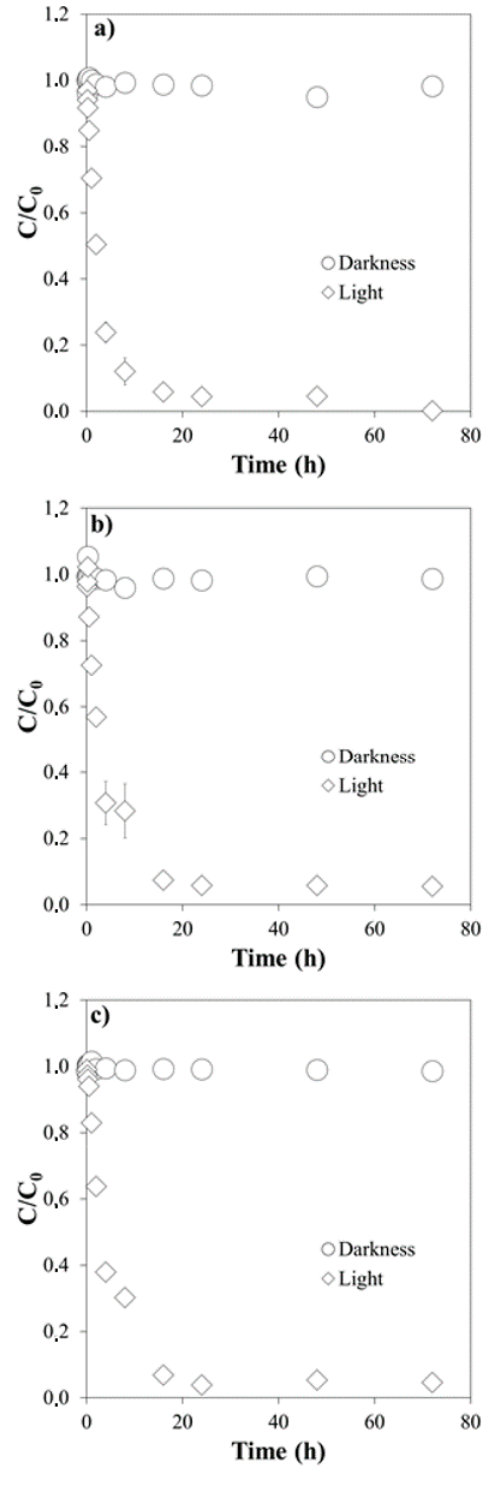
Figure 2. Degradation of Clarithromycin under simulated light and in the dark: ( a ) at pH 4.0; ( b ) at pH 5.5; ( c ) at pH 7.0. C/C 0 is the fraction of the initial concentration ( C 0 ) that remains in the suspension after a given time t. Even slower was the degradation of Tri. After 1 h of exposure to simulated light, it reached less than 5%, at any of the three pH values tested (Figure 3).